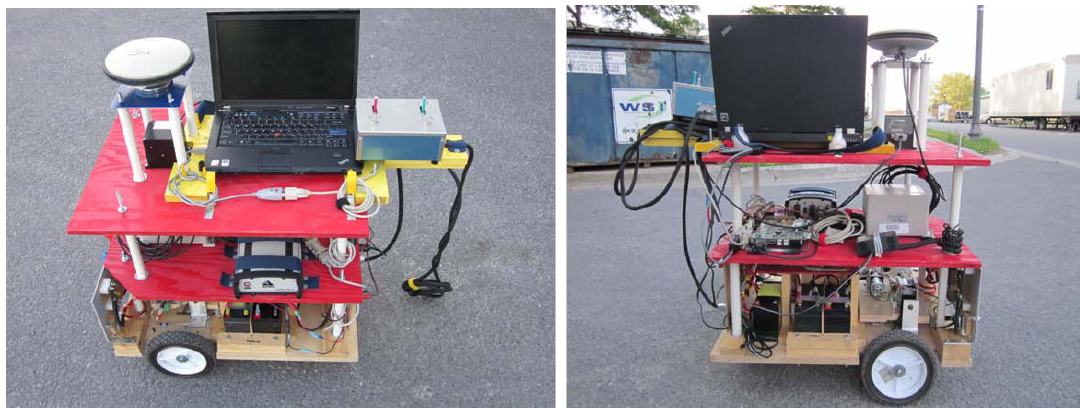
Figure 9. The Mobile Robot Testing Platform.